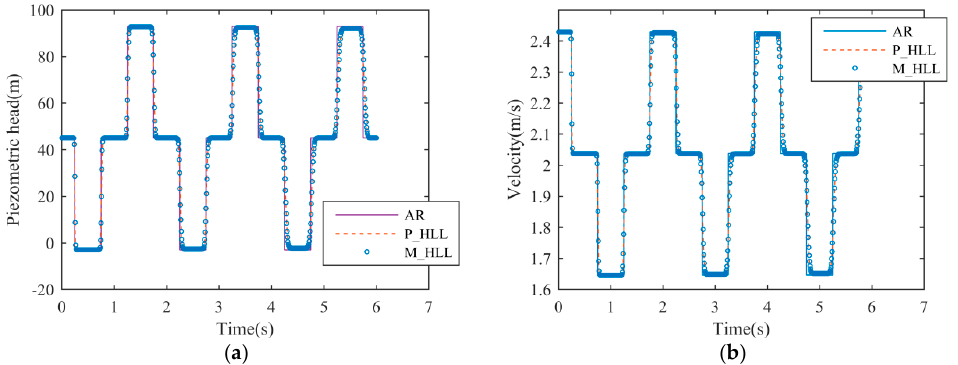
Figure 18. Locus of the flow states at the midpoint of the pipe simulated by P_HLL ( P a = 100 and P b = 0.8), M_HLL ( K a = 1.2 and NS = 12) and the analytical result (AR): ( a ) piezometric head; ( b ) flow velocity.